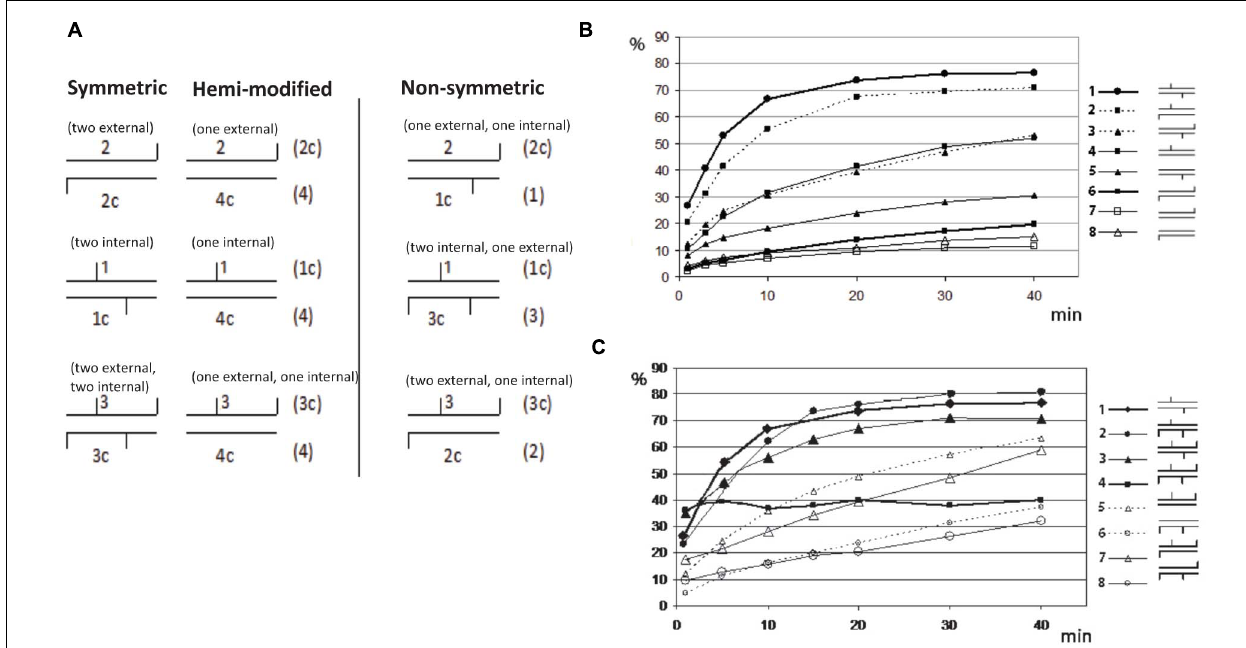
FIGURE 8 | Restriction of GCNGC oligo duplex with one to four m5C. (A) Schematic diagram of possible combination of m5C in GCNGC sites. Horizontal lines indicate DNA strands of oligo duplexes, vertical lines indicate m5C as internal (e.g., Gm5CNGC) or external (e.g., GCNGm5C). The names of the corresponding oligos are given above and below each duplex. Alternative variants of oligo duplexes with the same methylation pattern are given on the right in brackets. (B) BisI digestion of oligo duplexes with one (hemi-methylated) or two m5C. Percentage of cleavage (%) ( Y axis) is plotted vs. the time of reaction ( X axis). Schematic symbols for the methylation type are given on the right: 1 = 1*/1c (two internal m5C, * indicating 32 P labeled), 2 = 1*/2c (one internal and one external m5C), 3 = 2*/1c (one internal and one external m5C), 4 = 1*/4c (one internal m5C), 5 = 4c*/1 (one internal m5C), 6 = 2c*/2 (two external m5C), 7 = 2c*/4 (one external m5C), 8 = 4*/2c (one external m5C). (C) BisI digestion of oligo duplexes with two to four m5C (% of cleavage in Y axis is plotted vs the time of reaction ( X axis)). Schematic symbols of methylation type are given on the right: 1 = 1*/1c (two internal m5C), 2 = 1*/3c (two internal and one external m5C), 3 = 3*/1c (two